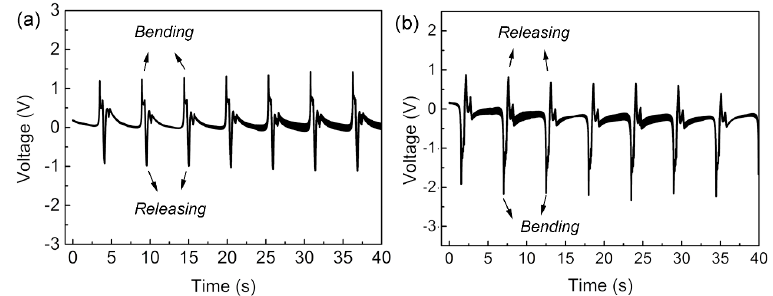
Figure 5. The output voltage generated by the NaNbO 3 sensor with the electrodes connected ( a ) straight and ( b ) in reverse to the DAQ system.